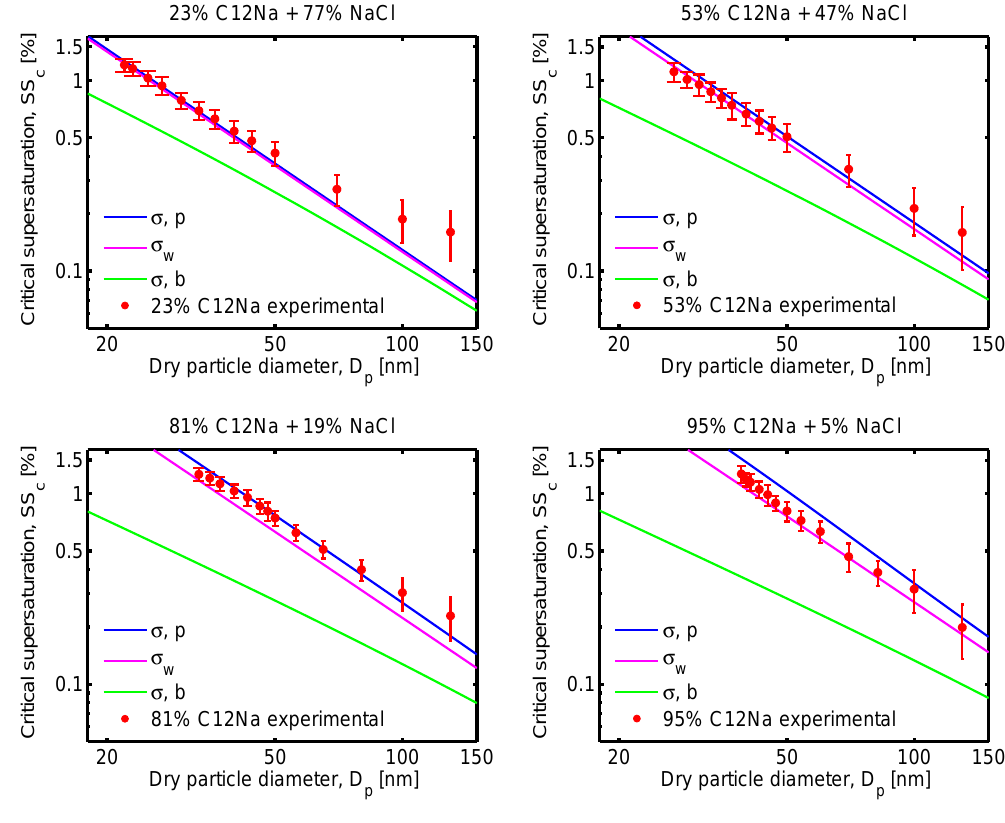
Fig. 4. Critical supersaturations ( SS c [ % ] ) as functions of dry particle diameter ( D p [nm]) for particles with sodium dodecanoate (C12Na) in dry mass fractions ( W p, C12Na ) of (a) 23%, (b) 53%, (c) 81%, and (d) 95%, measured in experiments and modeled with the three different surfactant representations ( σ,p , σ,b , and σ w